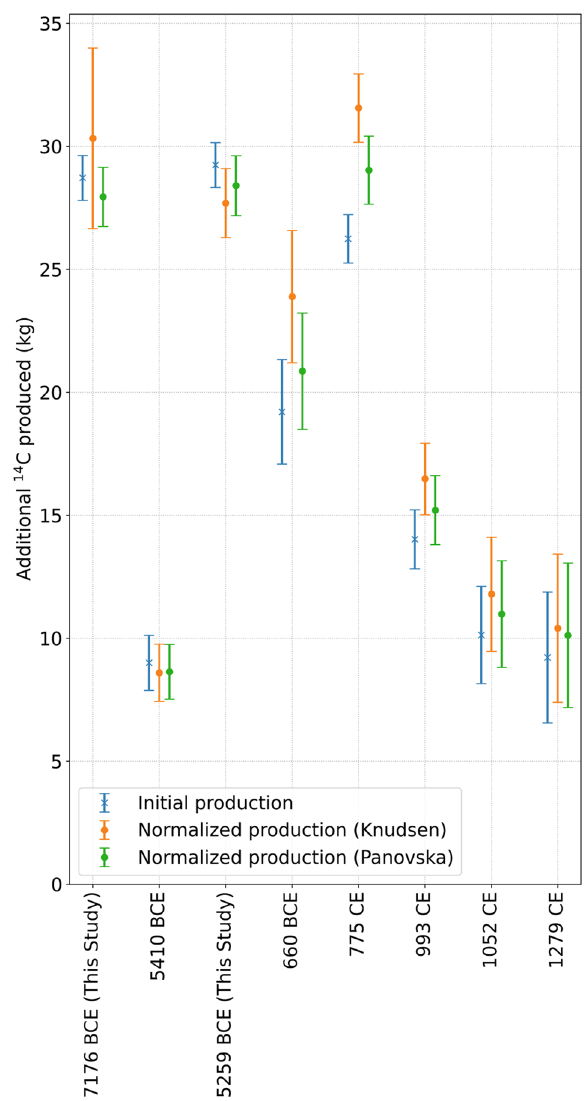
Fig. 3 Initial and normalized event productions. Excess 14 C produced during the events (blue) in comparison to the excess 14 C production normalized to today ’ s geomagnetic fi eld strength using two different records (orange Knudsen 41 , green Panovska 40 ) with 1- σ error bars for all known 14 C